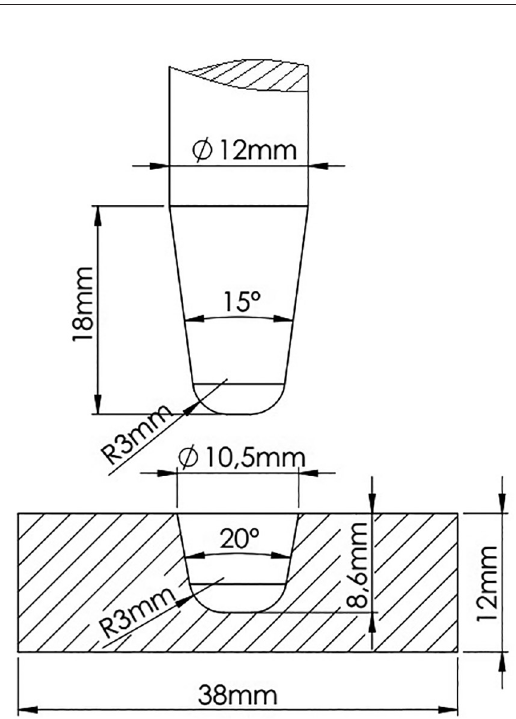
Figure 3: Dimensions of tapered consumable plugs and tapered hole. Table 2: Welding parameters. Rotational Sample